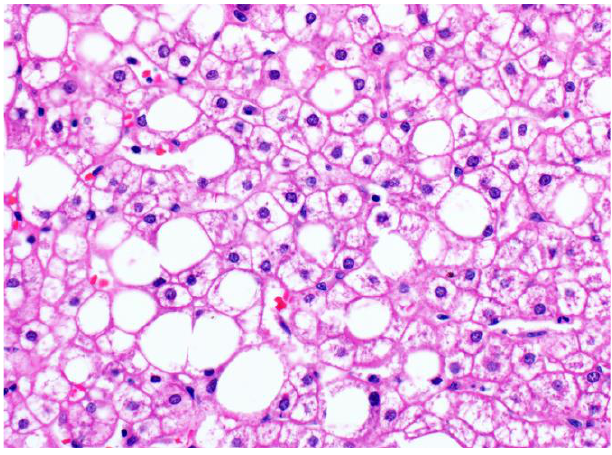
Figure 4. Patchy glycogenosis in NAFLD (original magnification 400×). The empty rounded spaces are large lipid droplets displacing the cell nuclei, while the glycogenated hepatocytes show cytoplasmic pallor but retain the central position of the nuclei and angular cell contours.